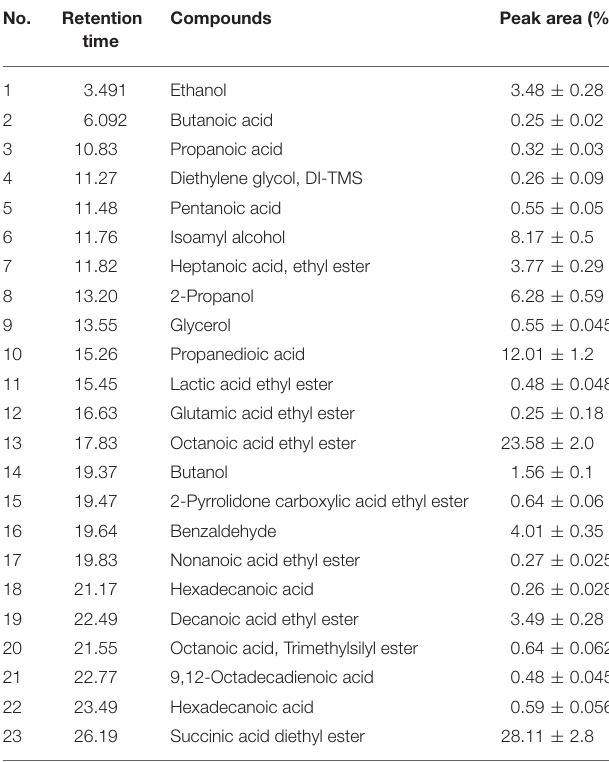
TABLE 8 | Compound identified fermented rice by GC-MS